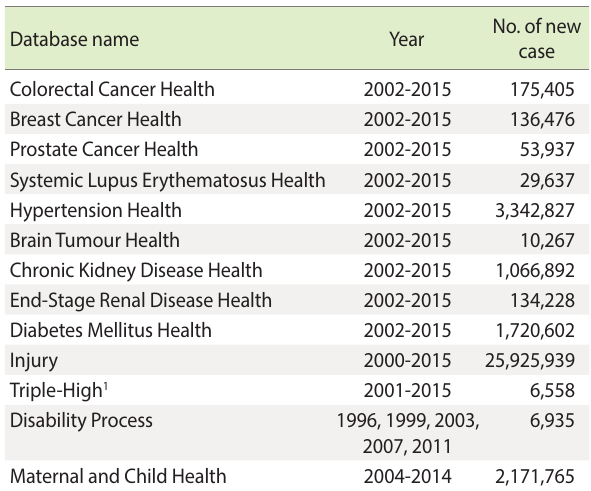
Table 1. Disease-specific databases of the National Health Insur-